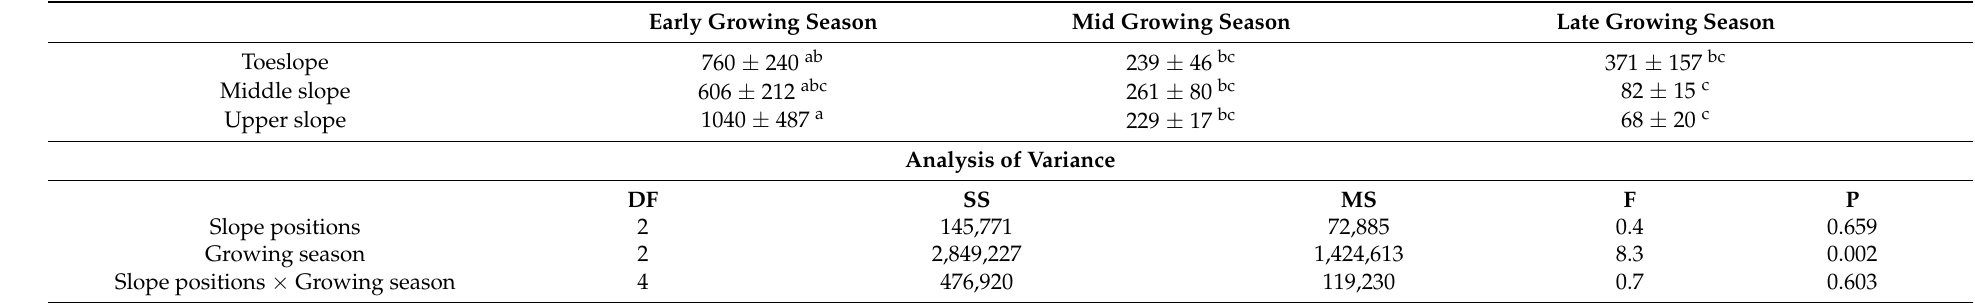
Table 2. Soil cumulative N 2 O emissions (g ha − 1 ) from different slope positions during early (26 May to 3 June), mid (21 June to 9 August), and late growing season (23 August to 10 October) during 2019 from Baggs farm. Means sharing different letters are significantly different from each other (LSD, p <